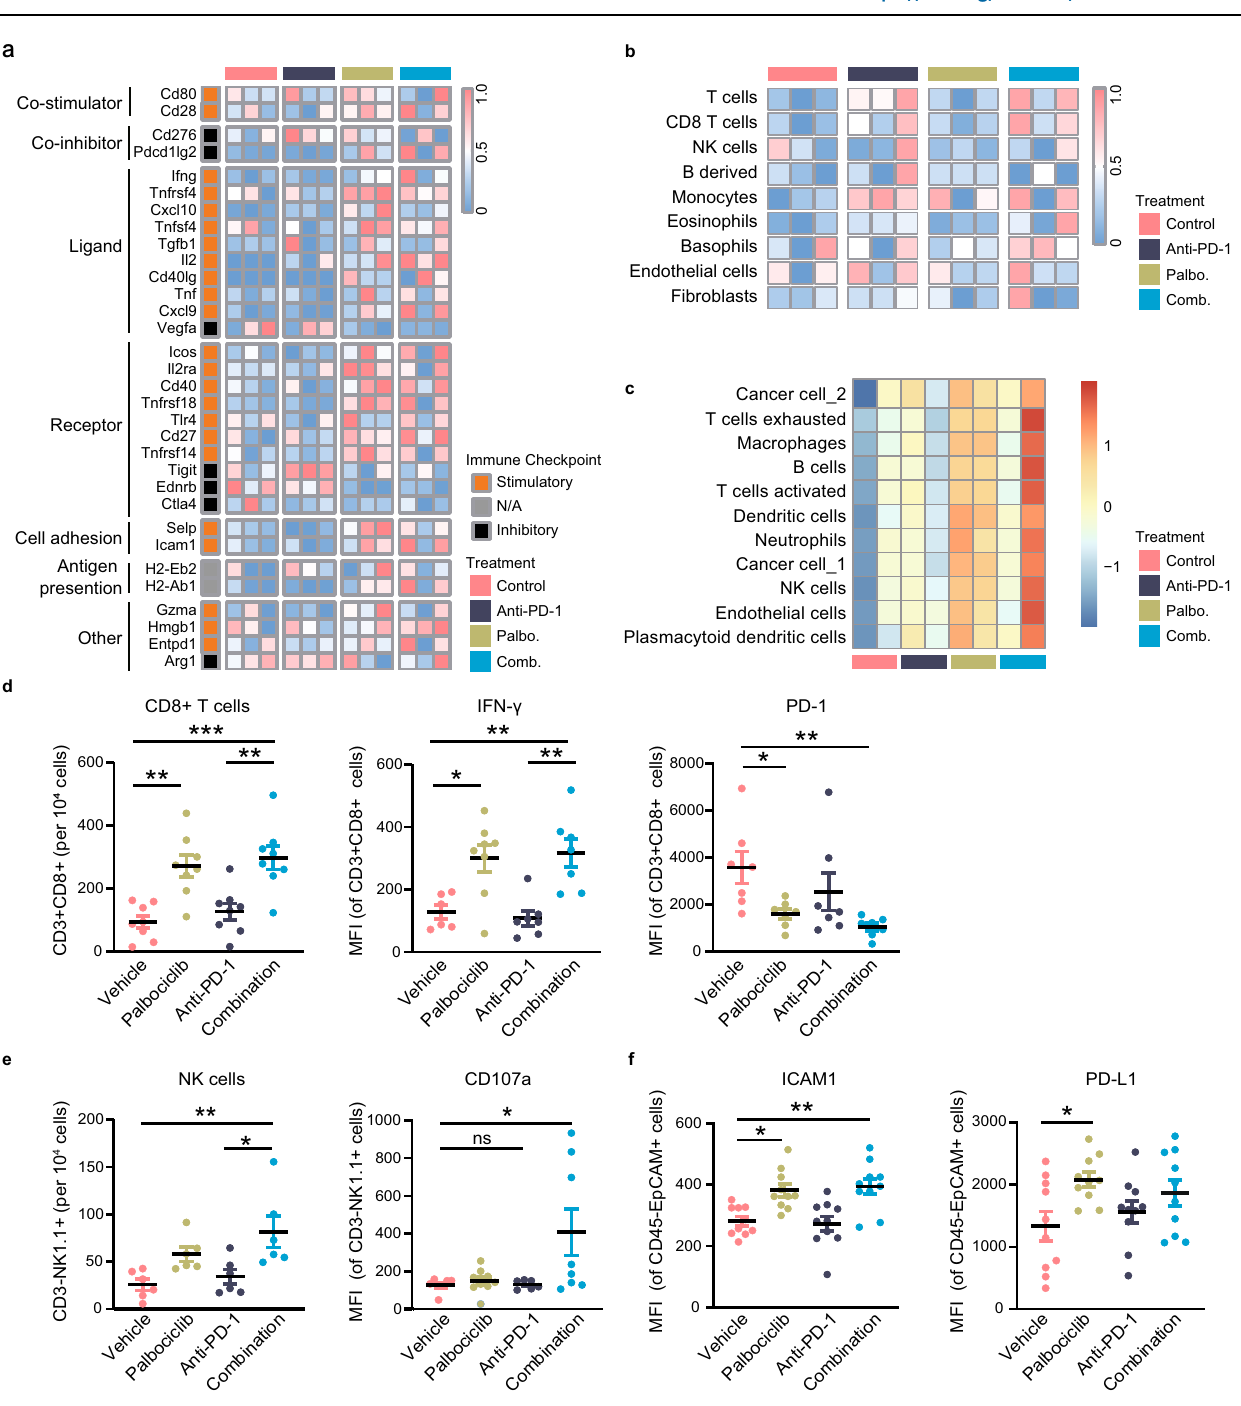
Fig.7|UsingCDK4/6inhibitorandanti-PD-1antibodytriggersanactivetumor immune microenvironment. a – c RNA-sequencing of murine tumor